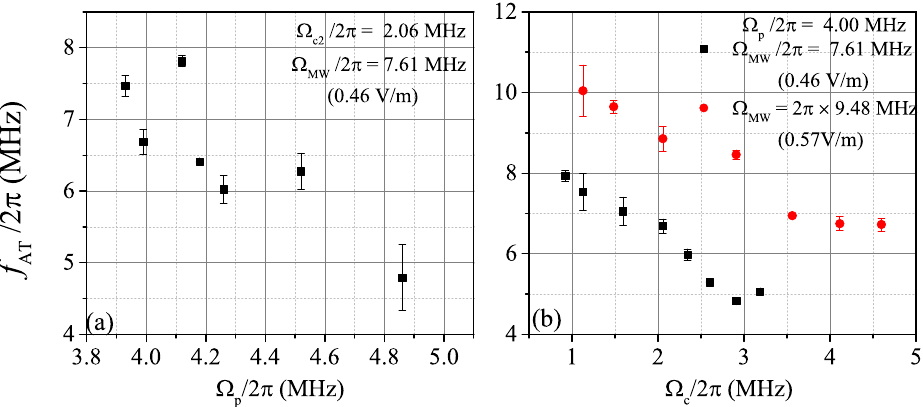
Figure 4. (color online) Measurements of f AT as a function of probe Rabi frequency Ω p ( a ) and coupling Rabi frequency Ω c ( b ) for fixed microwave electric field Ω MW /2 π = 7.61 MHz and 9.48 MHz, corresponding to electric field E = 0.46 V/m and 0.57 V/m, respectively. The error bars show the standard error of four times